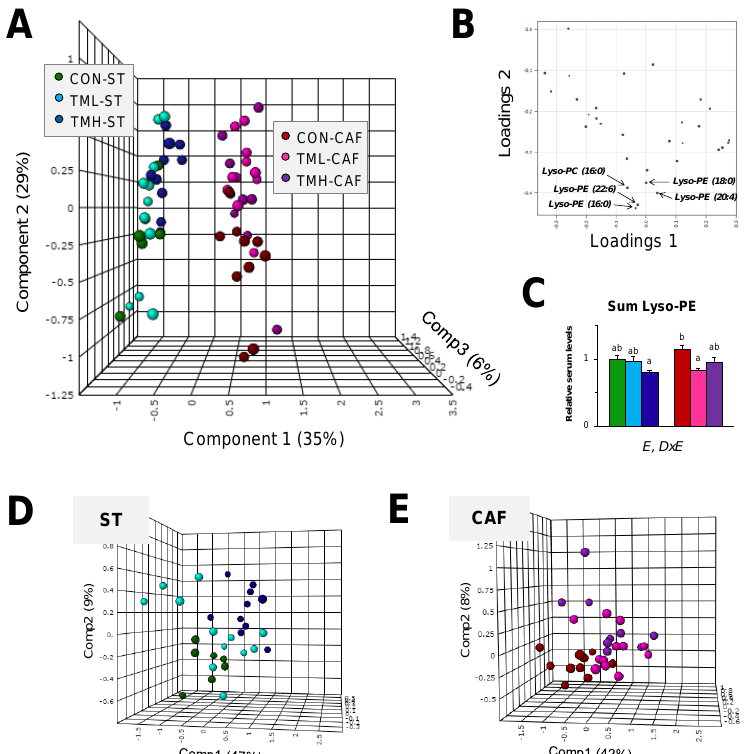
Figure 3. Identification of biomarkers of the daily practice of physical exercise. ( A ) Three-dimensional scores plot of partial least squares discriminant analysis of the thirty-one Lyso-PLs detected in rat serum. Each spot represents an animal colored according to both diet (ST or CAF) and intensity of training performed on a treadmill (CON: 0; TML: 12; TMH: 17 m/min) for 2 months. ( B ) Two-dimensional loadings plot showing the main underlying Lyso-PLs responsible for the discrimination between trained groups. ( C ) Total sum of the serum Lyso-PE levels (thirteen molecular species). The data are presented as means ± SEM ( n = 9 – 12). The statistical comparison among the animal groups was conducted using two- and one-way ANOVA. E: the effect of exercise; DxE: the interaction between diet and exercise (two-way ANOVA, p < 0.05). abc: Mean values with different lowercase letters were significantly different (one-way ANOVA and Tukey post hoc contrast, p < 0.05). Separate score plot for ST ( D ) and CAF ( E ) groups showing the slight influence of exercise on the Lyso-PL